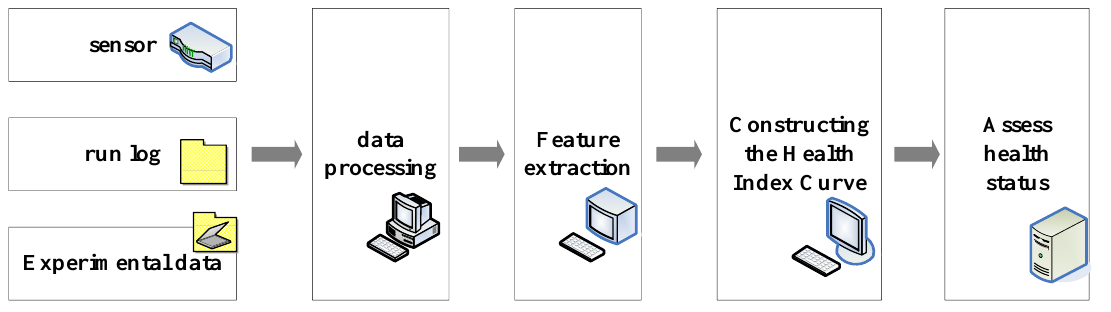
Figure 2. Health-status-assessment process.